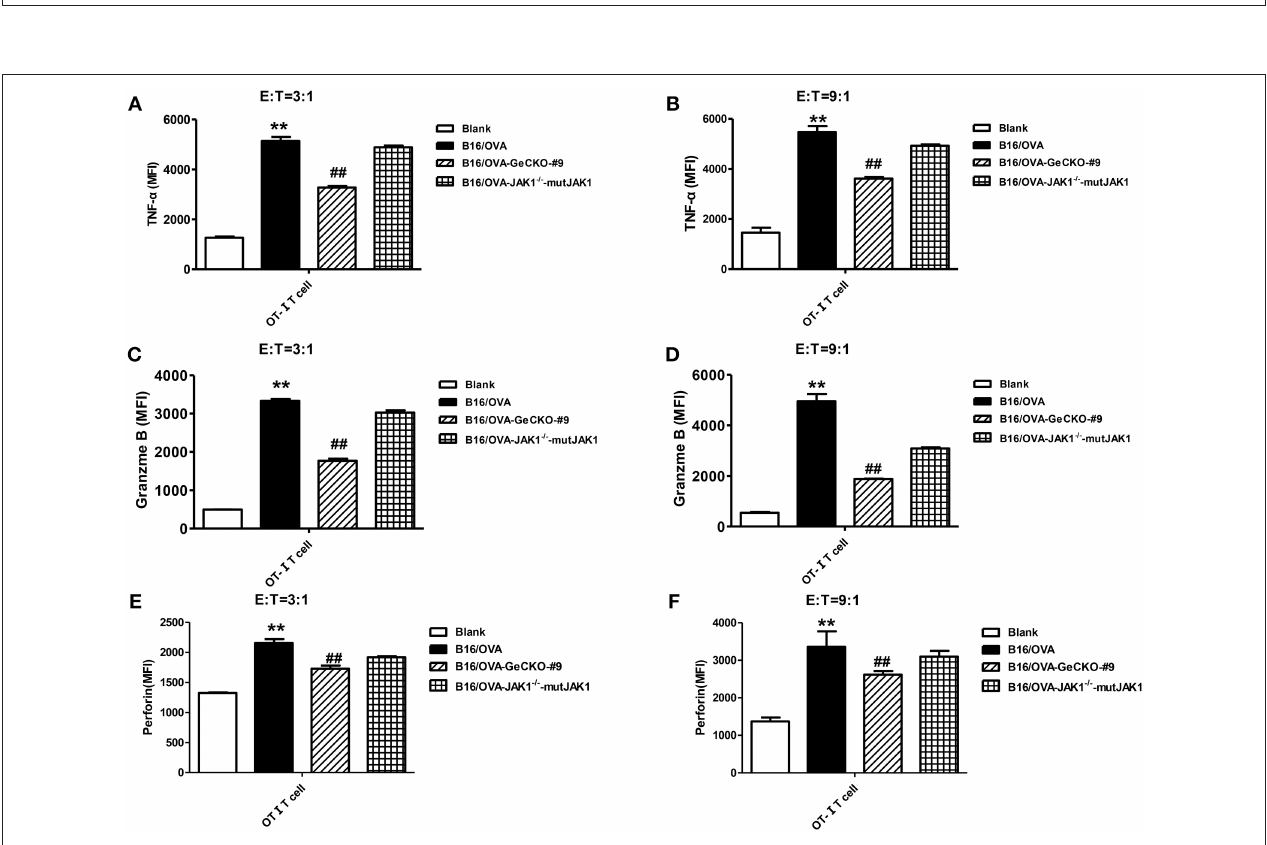
FIGURE 4 | Loss of JAK1 decreases the cytotoxicity of T-cells. OT-I T-cells and indicated B16/OVA cells and their derivatives were co-cultured (E: T = 3:1 or 9:1) for 48h, and the production of TNF- α (A,B) , granzyme B (C,D) , and perforin (E,F) were analyzed by intracellular flow cytometry. Data are presented as mean ± SEM. ** P < 0.01 vs. blank group; ## P < 0.01 vs. B16/OVA + OT-I T-cell group.